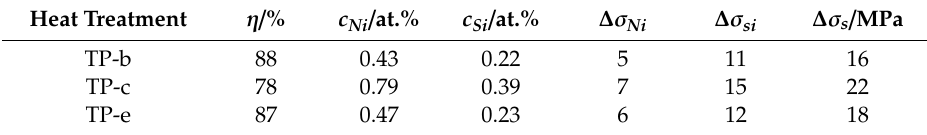
Table 8. Relevant parameters and calculated results of the solid solution